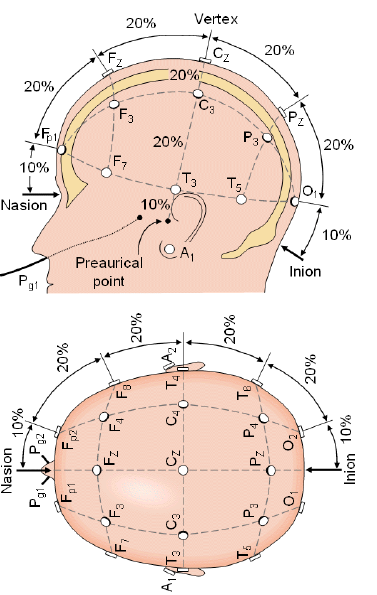
Fig. 1. Electrode placement in accordance with the "10-20" system